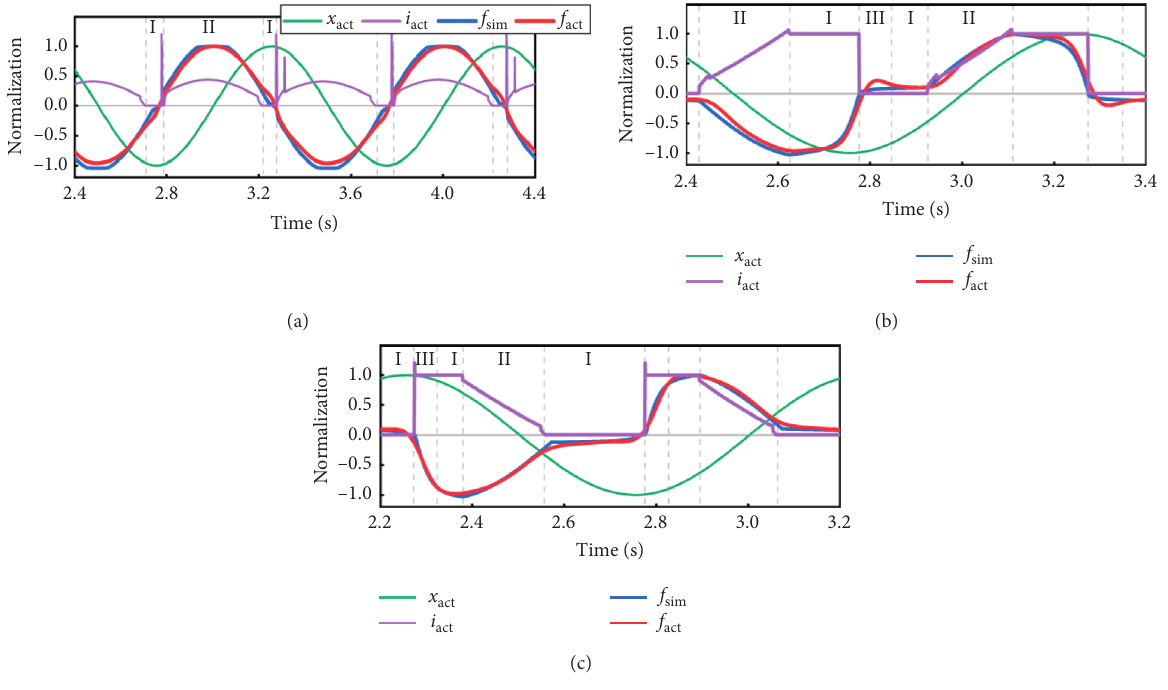
Table 4: RMSE between f